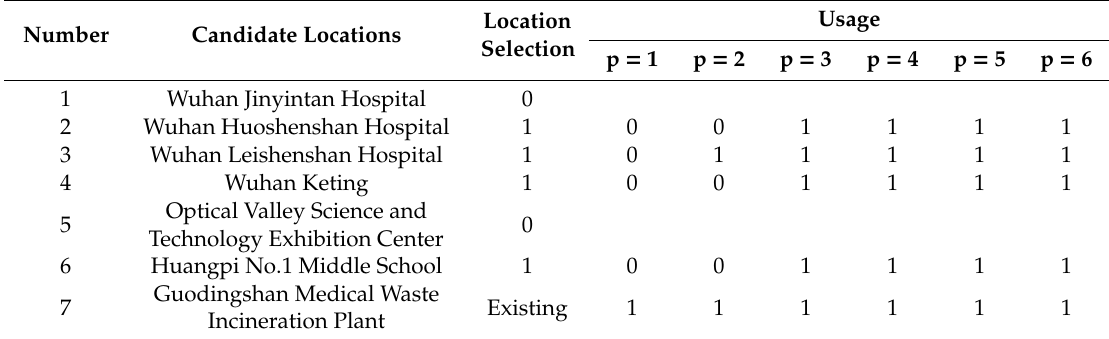
Table 7. Location decisions and facility usage in each period.